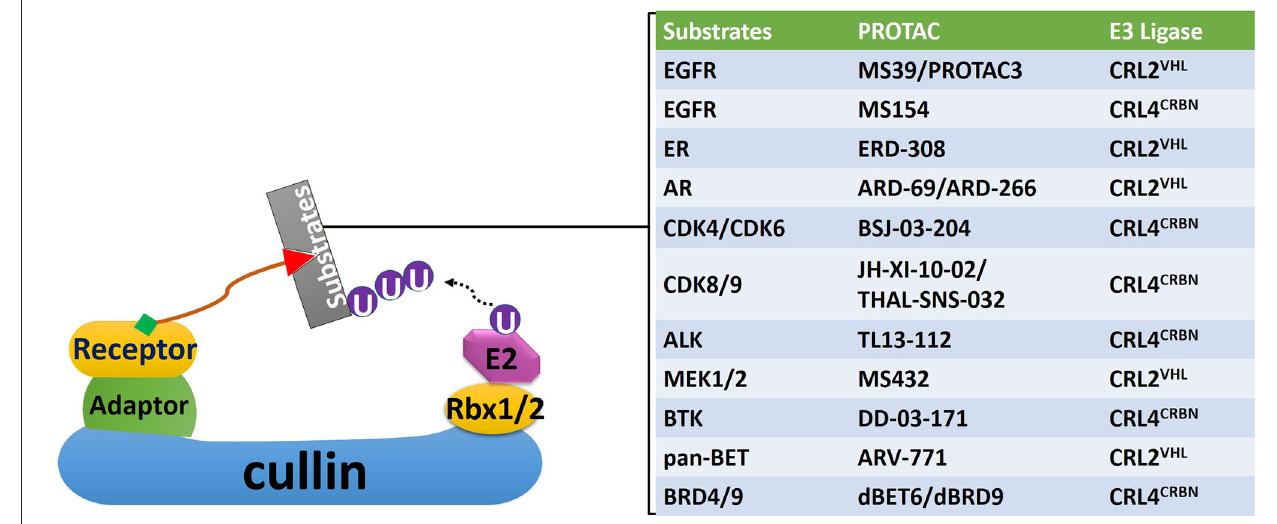
FIGURE 4 | A non-exhaustive list of PROTACs targeting proteins related with the development of radioresistance. Corresponding CRLs that mediate polyubiquitination of these proteins were also identified. EGFR, epidermal growth factor receptor; ER, estrogen receptor; AR, androgen receptor; CDK, cyclin-dependent kinase; ALK, anaplastic lymphoma kinase; MEK, mitogen-activated protein kinase kinase; BTK, Bruton tyrosine kinase; BET, bromodomain and Extra-Terminal motif; BRD, bromodomain. mechanism of these novel compounds is essential for developing next-generation